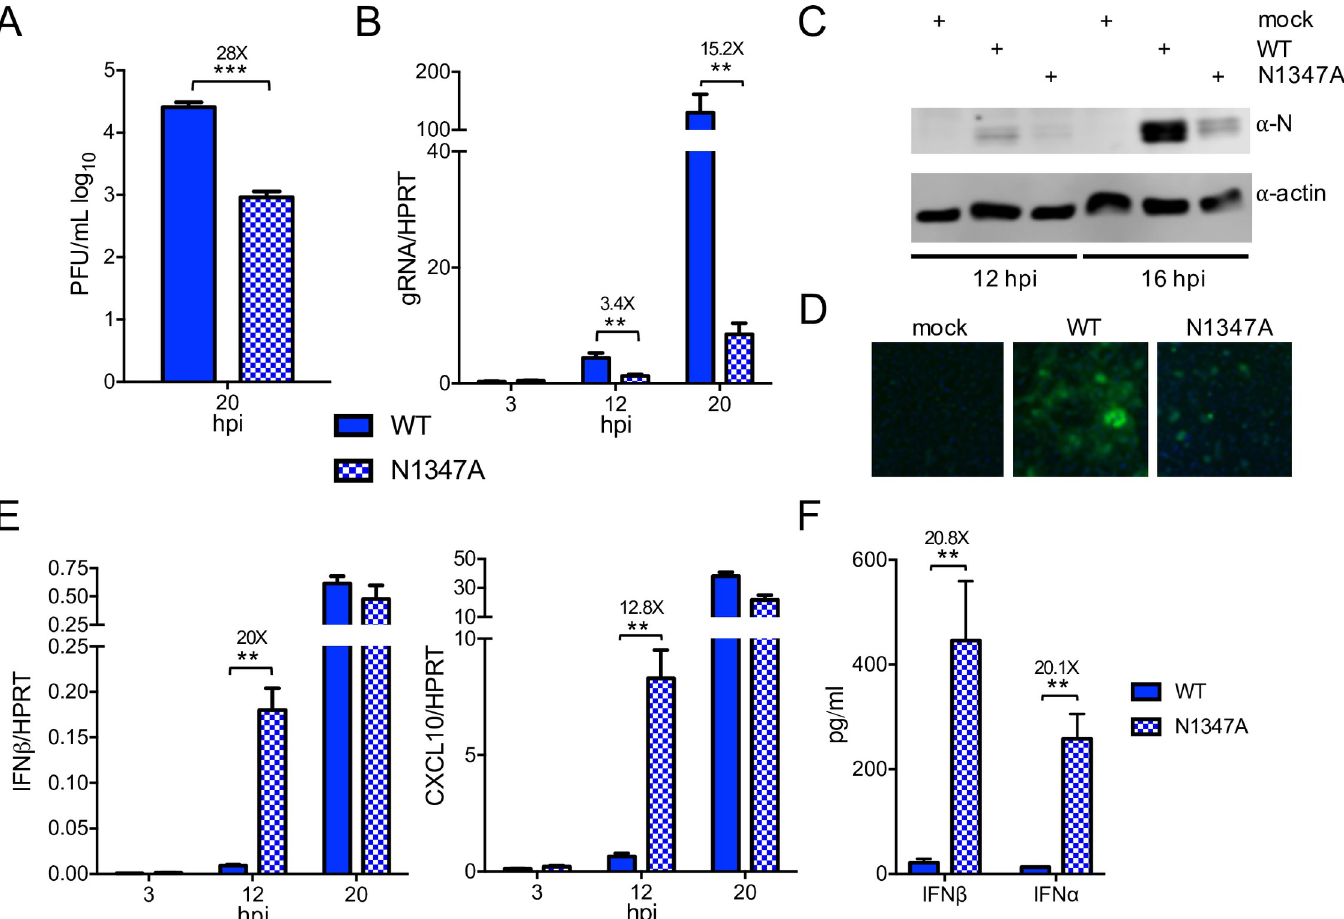
Fig 1. N1347A MHV replicated poorly and induced an increased IFN response in BMDMs. (A-D) BMDMs were infected with WT or N1347A MHV and analyzed for virus replication. (A,B) Virus titers (A) and genomic RNA (gRNA) levels (B) were determined by plaque assay and RT-qPCR with primers specific for nsp12 (normalized to HPRT) respectively. (C,D) BMDMs were infected as described above, and at 14 hpi viral protein levels were determined by immunoblotting infected cell lysates with anti-nucleocapsid protein (N) antibody (C) or visualized by fluorescence microscopy (D). (E) Infected BMDMs were collected at indicated time points, and RNA levels were determined by RT-qPCR with primers specific for each transcript and normalized to HPRT. (F) BMDMs were infected as described above, and at 12 hpi, supernatants were collected and analyzed for IFN α and IFN β protein levels by ELISA. The data in (A-E) are obtained from one experiment representative of two independent experiments; n = 3 biological replicates. The data in (F) are combined from two independent experiments; WT, n = 6; N1347A, n = 7. Numbers above bars represent fold difference between WT and N1347A.